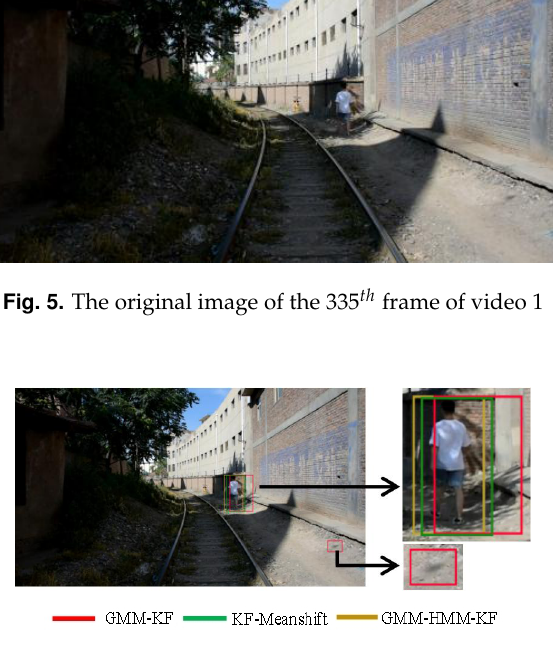
Fig. 6. The results of processing using three algorithms